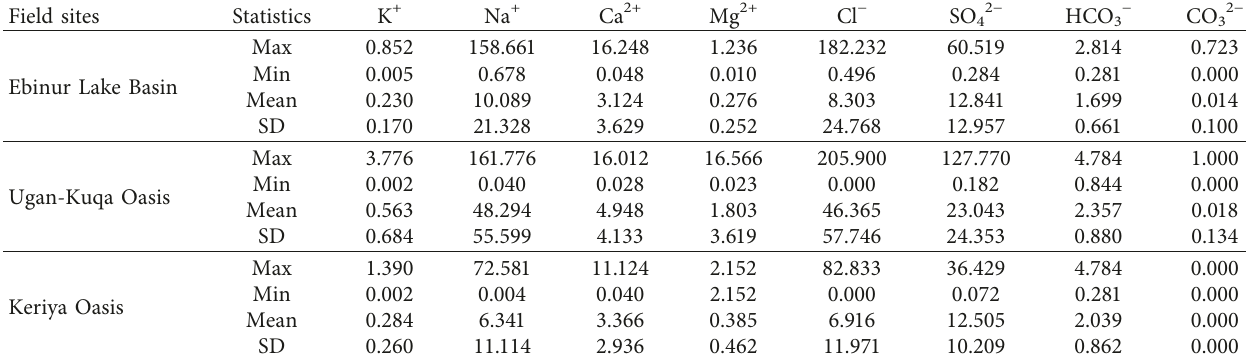
Table 4: Statistical characteristics of the eight major ions in sampling area soil (g · kg − 1 ).